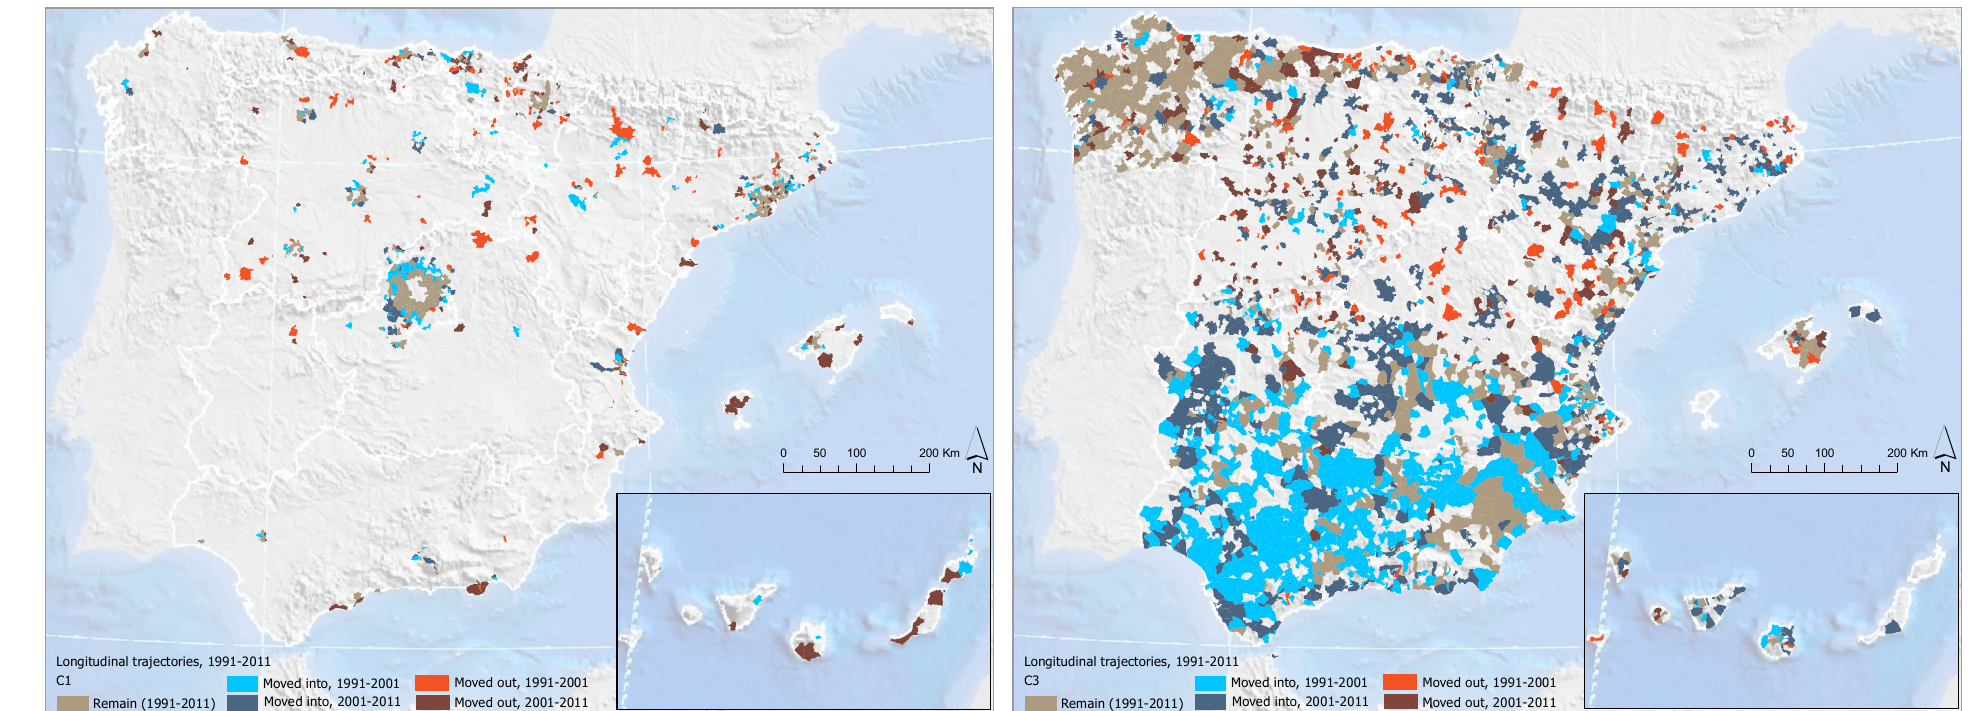
Figure A6. Visualization of longitudinal trajectories from a geographical perspective (part